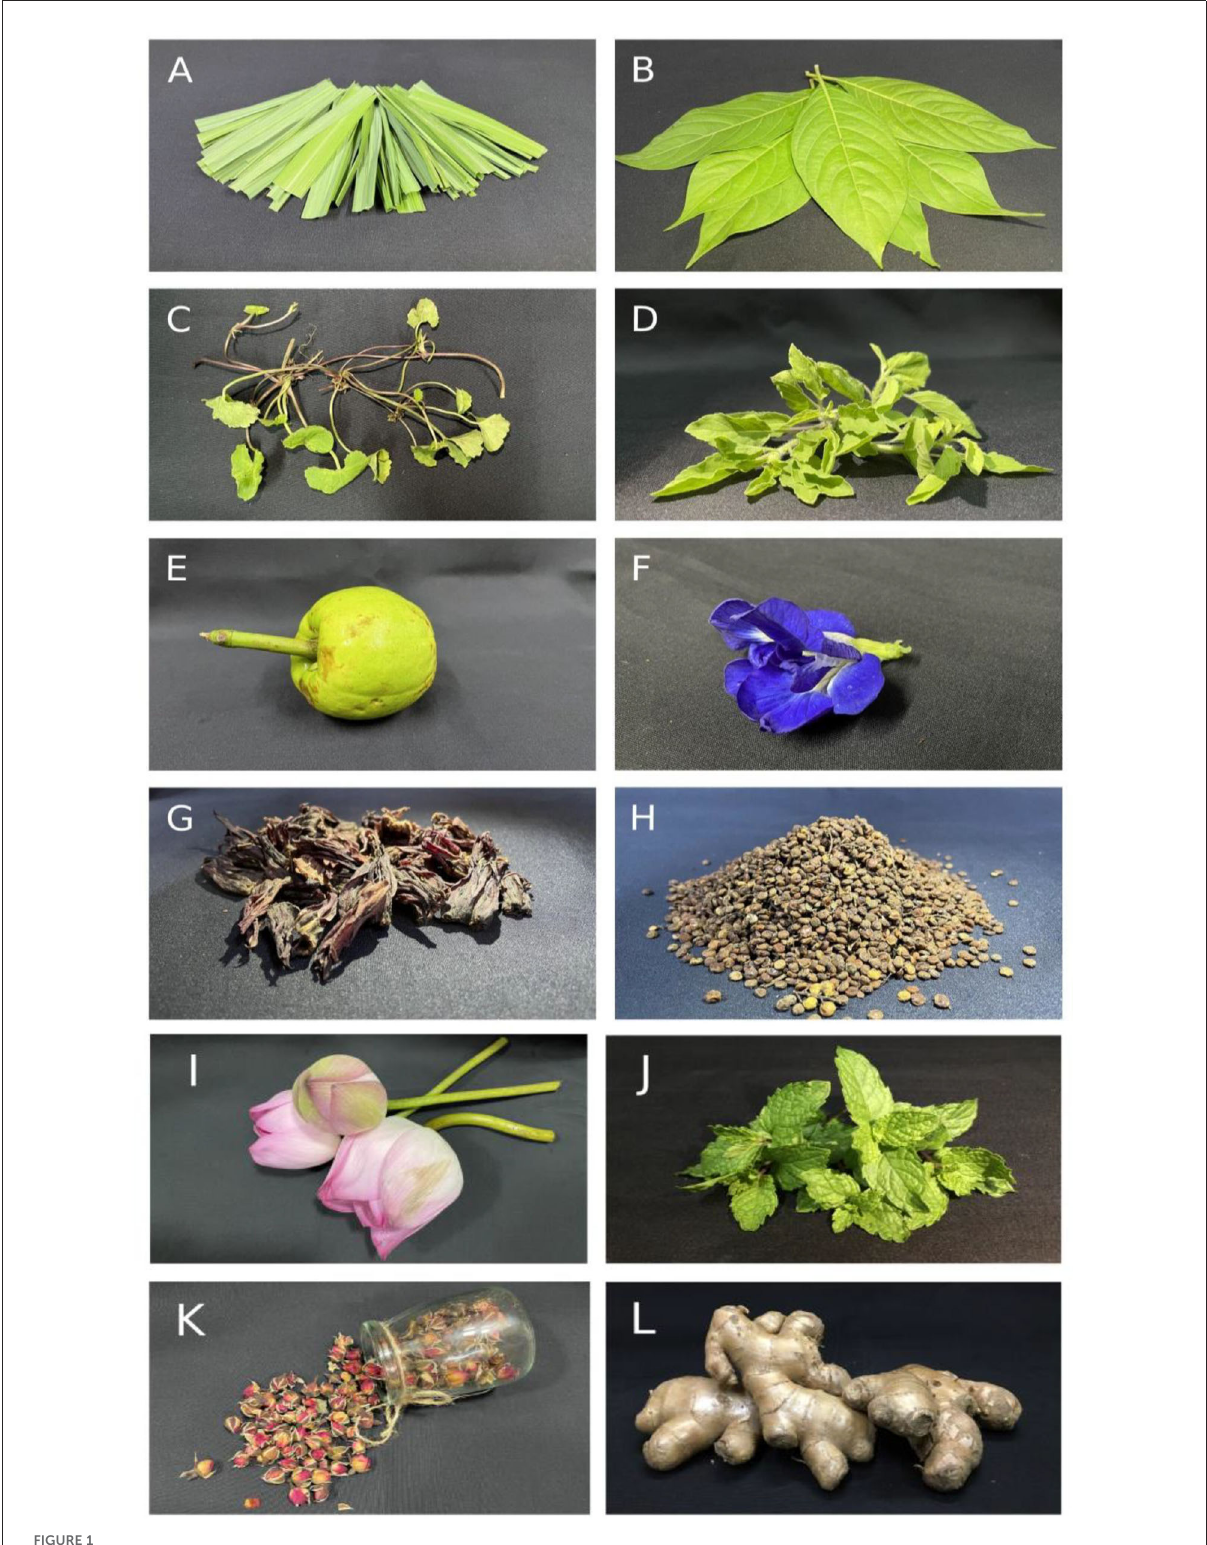
FIGURE1 Pictures of different plants that are consumed as herbal tea studied in the current review. (A) Lemongrass ( Cymbopogon citratus ); (B) Nongmangkha ( Phlogacanthus thyrsiformis ); (C) Peruk ( Centella asiatica ); (D) Holy Basil/Tulsi ( Ocimum sanctum ); (E) Heibung ( Garcinia pedunculata ); (F) Blue pea ( Clitoria ternatea ); (G) Roselle ( Hibiscus sabdariffa ); (H) Heimang ( Rhus chinensis ). (I) Nelumbo nucifera (Lotus), (J) Mentha spicata (Spearmint), (K) Rosa damascena (Rose), and (L) Zingiber officinale